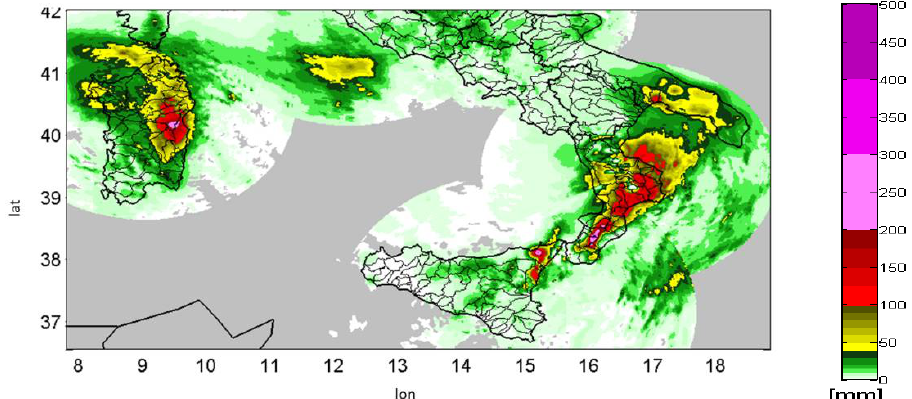
small scale of the event.